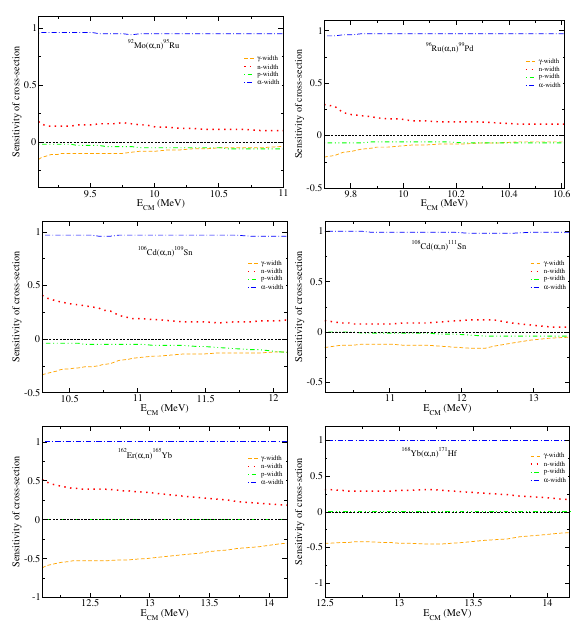
Figure 2. ( α ,n) cross section sensitivity with the variation of α -, p-, n-, γ -width [12].